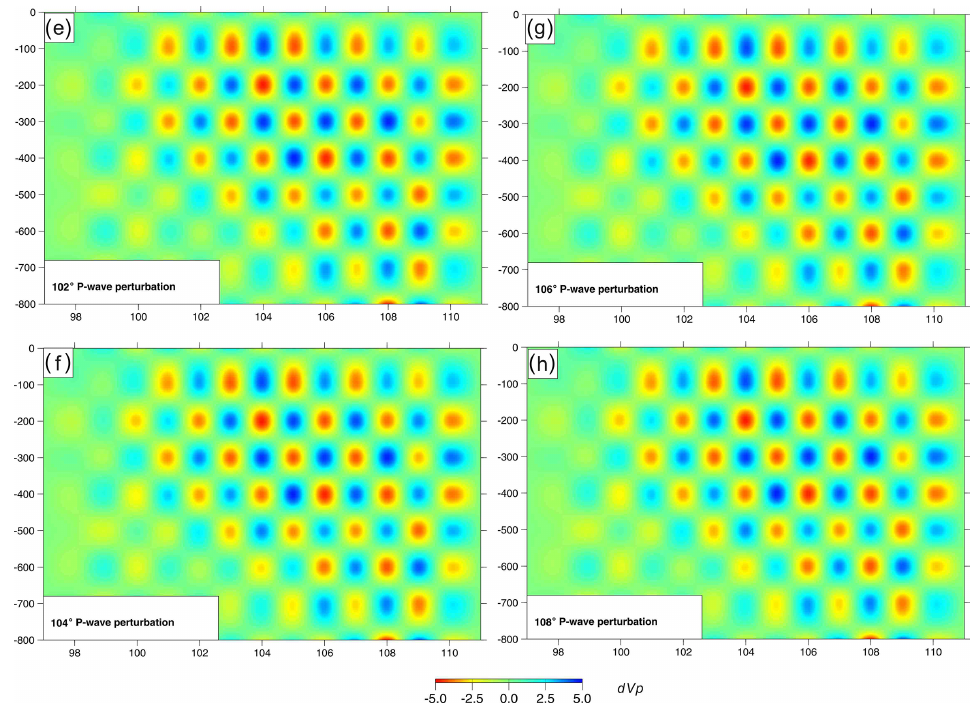
Figure 7. Checkerboard resolution test along the north–south profiles ( e , f , g , and h are sections along longitudes 102, 104, 106, and 108 ◦ E, respectively) (see Fig. 1 for profile